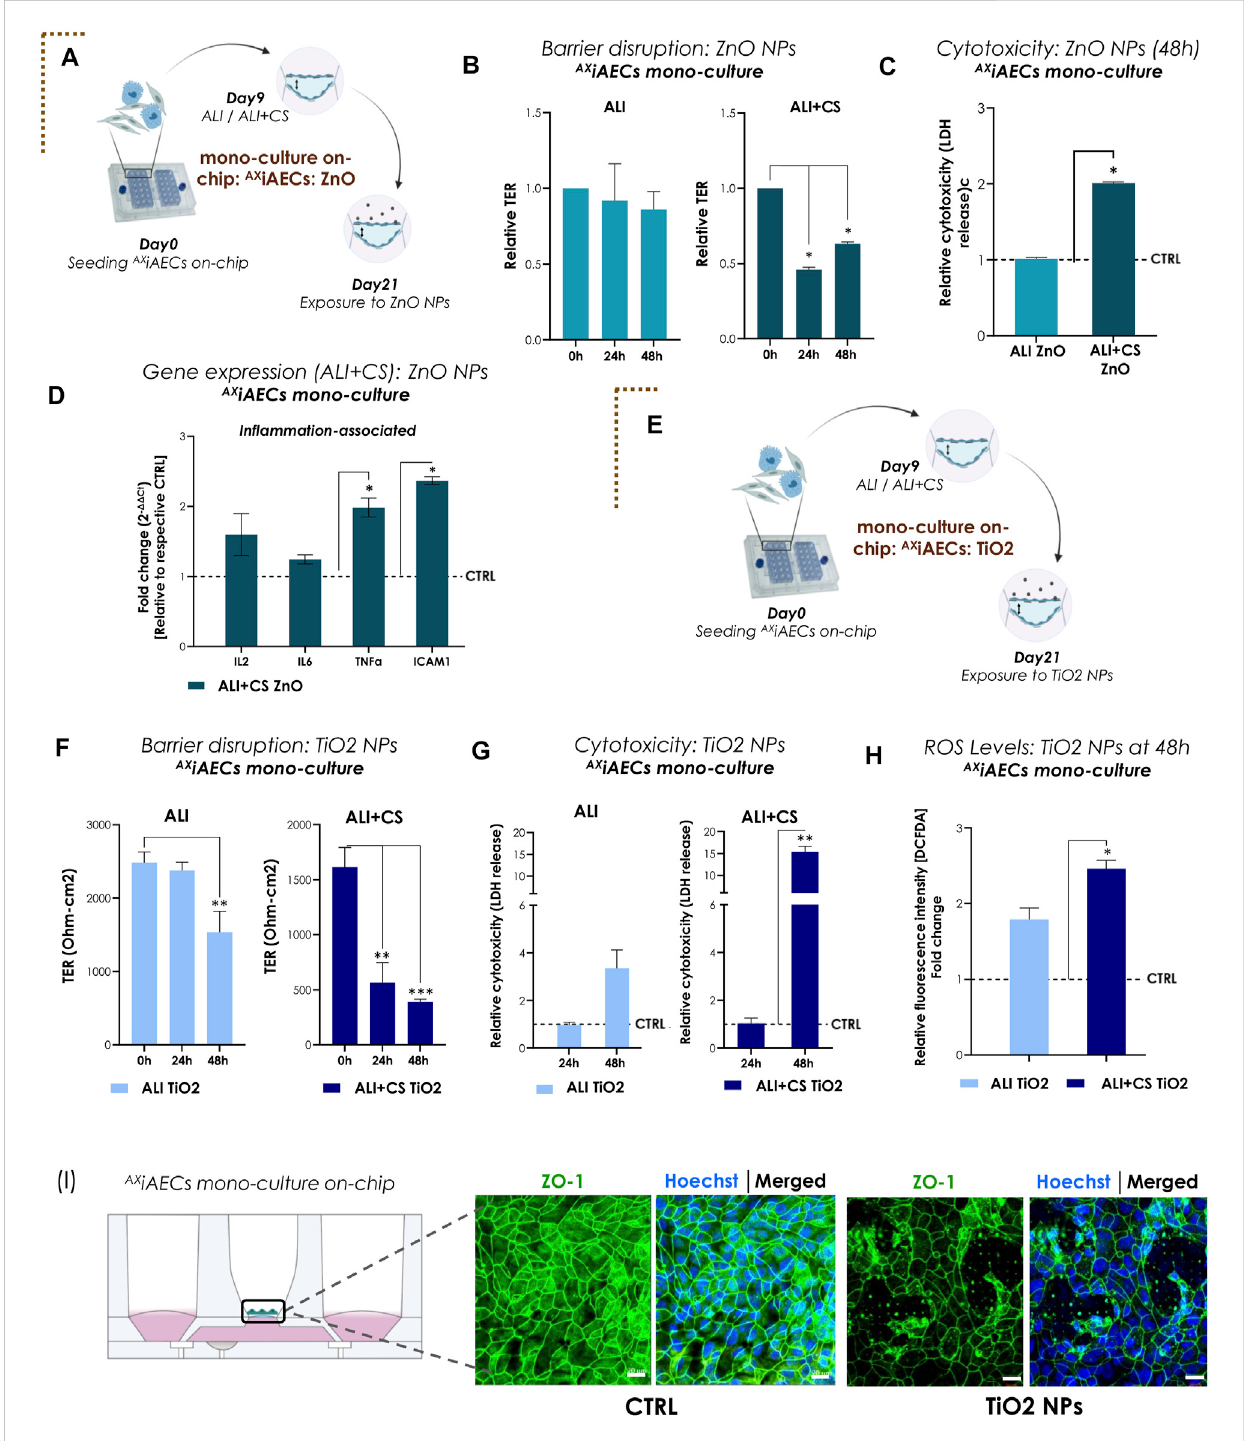
FIGURE 3 Nanoparticles (NPs)-induced in fl ammation and barrier disruption in AX iAECs mono-culture on-chip (A) The brown dotted corner bracket suggests the distinctionbetweendifferenttrigger-inducedmodels.Onday21ofthemonocultureexperiment,the AX iAECswereexposedtotheZnONPson-chip.Timeline andschematicprovidefurtherdetailsoftheexperiment. (B) TERvalues(normalizedto0 htimepoint)forALIandALI+CScellculturesexposedtoZnONPs(n= 3/condition/timepoint). (C) RelativeLDHrelease(NPsexposedwithrespectto Control;CTRL)shownfor48 htimepointfor ALIandALI +CS cells(n=4). (D) mRNA was isolated from CTRL and ZnO exposed cells (ALI + CS) at 48 h exposure timepoint. qPCR studies were performed with n = 4/conditions and exposure signi fi cance were measured in relation to CTRL expression levels. (E) Results for AX iAECs mono-cell culture model with TiO2 NPs is denoted by openinganotherbrowndottedcornerbracket.TimelineandschematicofTiO2NPsnebulizationonday21inmonoculture( AX iAECs)on-chip. (F) AbsoluteTER values (Ohm-cm2) comparedpre-TiO2 NPs exposure (at 0 h) with 24h and48 h after exposure (N = 2; n = 6). (G) Signi fi cance for cytotoxicity was calculated relativetorespectiveALIorALI+CSCTRL.CytotoxicitywascalculatedfromLDHreleaseat24hand48 hafterTiO2NPsnebulizationfrombothALIandALI+CS samples (N = 2; n = 4/time-point). (H) ROS generation was measured using the H2-DCFDA assay (N = 2;n = 4). Fluorescence intensity forexposed cells were normalized with respective healthy CTRL. (I) Representative immuno fl uorescence staining for alveolar barrier after 48 h of TiO2 NPs exposure. Cells were probed for tight junction, ZO1 (green) and nuclei with Hoechst (blue). Scale bar is 20 µm. Data are shown as mean ±